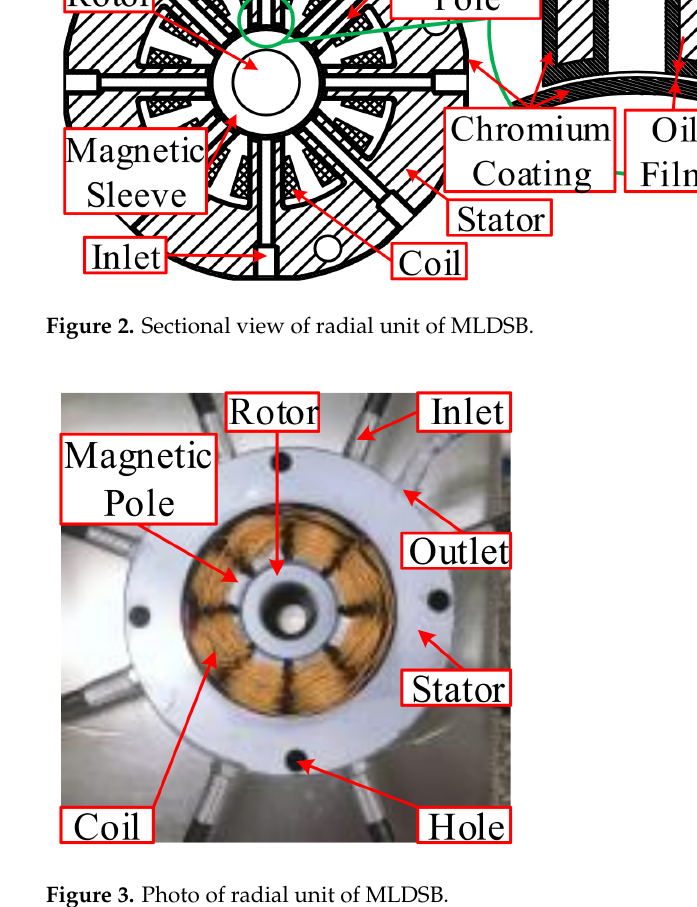
Figure 3. Photo of radial unit of